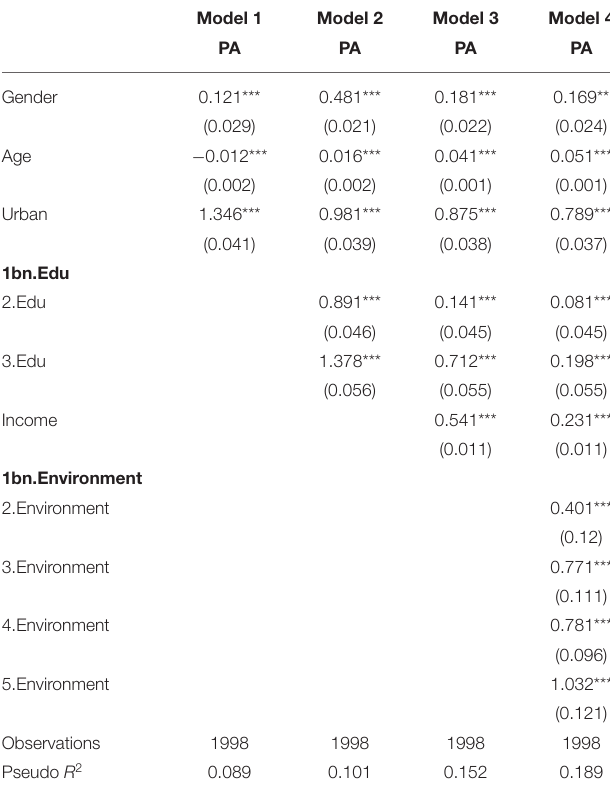
TABLE 2 | Regression analysis model of residents’ income, environmental factors and physical